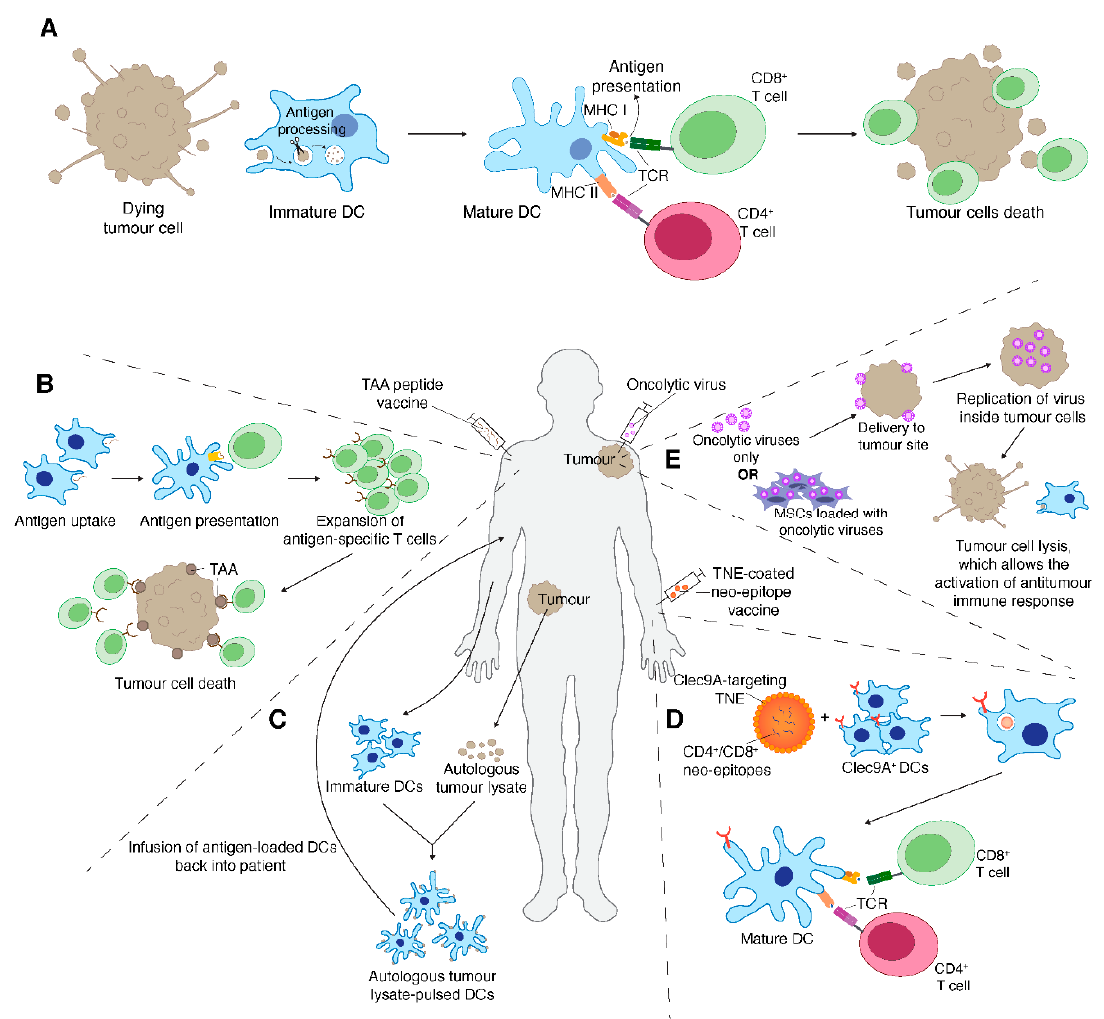
Figure 2. Schematic diagram of therapeutic cancer vaccine and oncolytic virus therapy. ( A ) Immature DCs process captured antigen from a dying tumour cell and undergo maturation. Mature DCs then present antigen to CD8 + and CD4 + T cell via its MHC I and MHC II molecules, respectively. Activated T cells can now recognise and lyse tumour cells. ( B ) Immunogenic TAA peptides are injected into patients to elicit an antigen-specific immune response. DCs can process and present these peptides to T cells, leading to expansion of antigen-specific T cells which can now target TAA-expressing tumour cells. ( C ) Through surgical resection or biopsy, the tumour sample is collected and processed into tumour lysate. Immature DCs are isolated from patient and pulsed with autologous tumour lysate. These tumour lysate-pulsed mature DCs are then infused back into patient to elicit an anti-tumour immune response. ( D ) CD4 + or CD8 + neo-epitopes are encapsulated in TNE that are recognised by Clec9A + DCs. Clec9A + DCs then effectively process and present these peptides to CD4 + or CD8 + T cell via MHC II or MHC I molecules. Activated T cells can now recognise and initiate tumour cell killing. ( E ) Oncolytic viruses are either injected directly into tumours or loaded into mesenchymal stem cells before reinfusion into patients. These viruses undergo replication that eventually causes tumour cell lysis, which allows DCs to capture and uptake tumour antigens to elicit anti-tumour immune response. DC, dendritic cell; MHC, major histocompatibility complex; MSCs, mesenchymal stem cells; TCR, T cell receptor; TAA, tumour-associated antigen; TNE, Tailored NanoEmulsion.